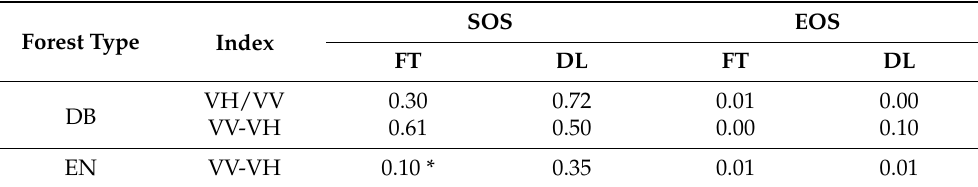
Figure 8. Correlations of phenological metrics in day of year between PhenoCam (x-axis) and satellite remote sensing (y-axis) in coniferous forests. ( a , e ): SOS extracted by FT; ( b , f ): EOS extracted by FT; ( c , g ): SOS extracted by DL; and ( d , h ): EOS extracted by DL. Red lines: VV-VH; and green lines: NDVI. Table 3. Correlation between Sentinel-1 and Sentinel-2 NDVI extracted phenological metrics (shown by R 2 values). Forest